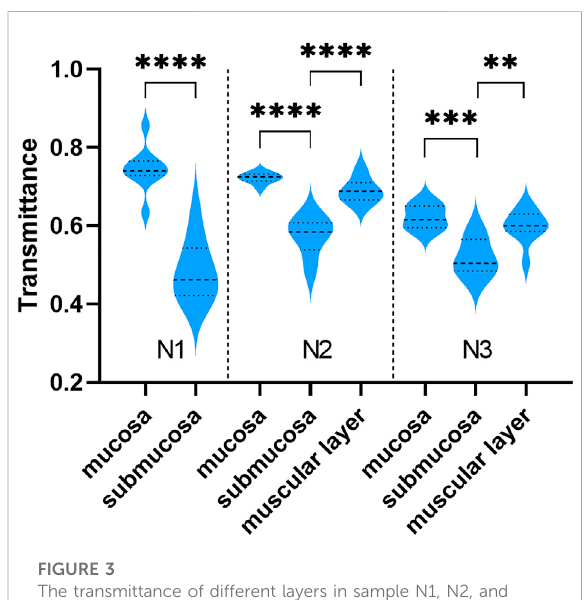
FIGURE 3 The transmittance of different layers in sample N1, N2, and N3. The transmittance of submucosa was lower than that of mucosa and muscular layer. ****: p < 0.0001, ***: p < 0.001, **: p <